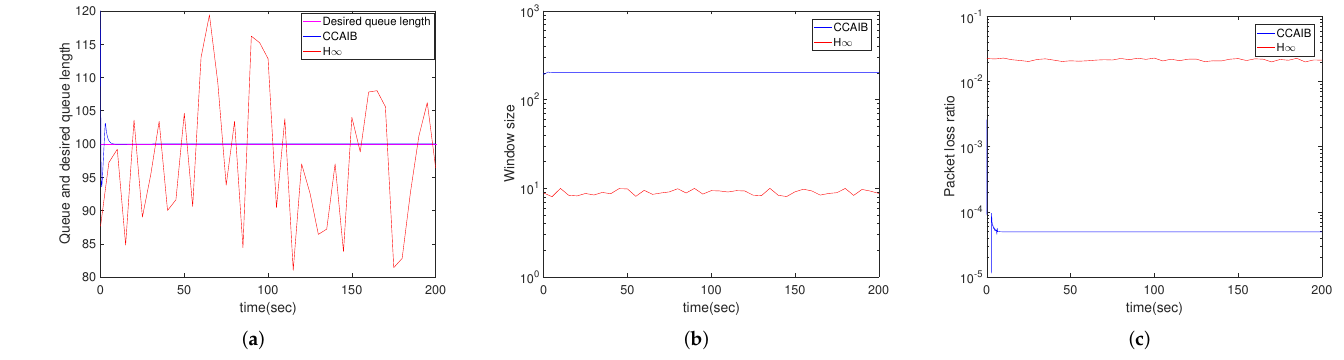
Figure 2. Simulation results of single router using CCAIB and H ∞ algorithm for case 1. Columns from left to right show the performance of CCAIB and H ∞ in ( a ) queue length stability, ( b ) window size and ( c ) packet loss ratio in the queue.